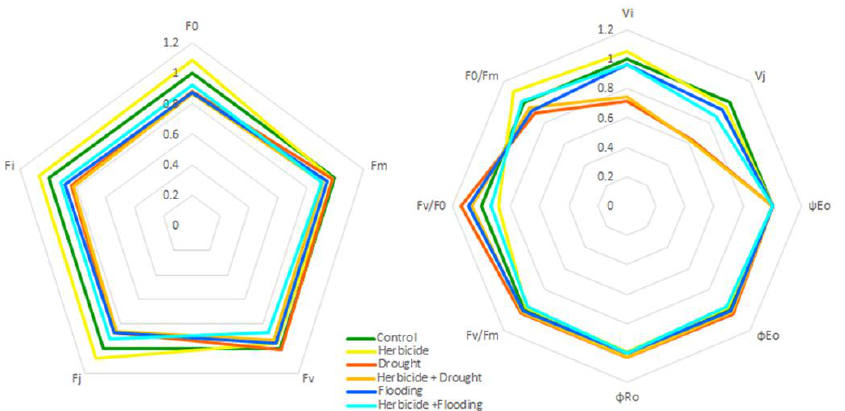
Figure 7. Spider plot of the chlorophyll fluorescence parameters in wheat plants after 4 days of recovery following drought or flooding.